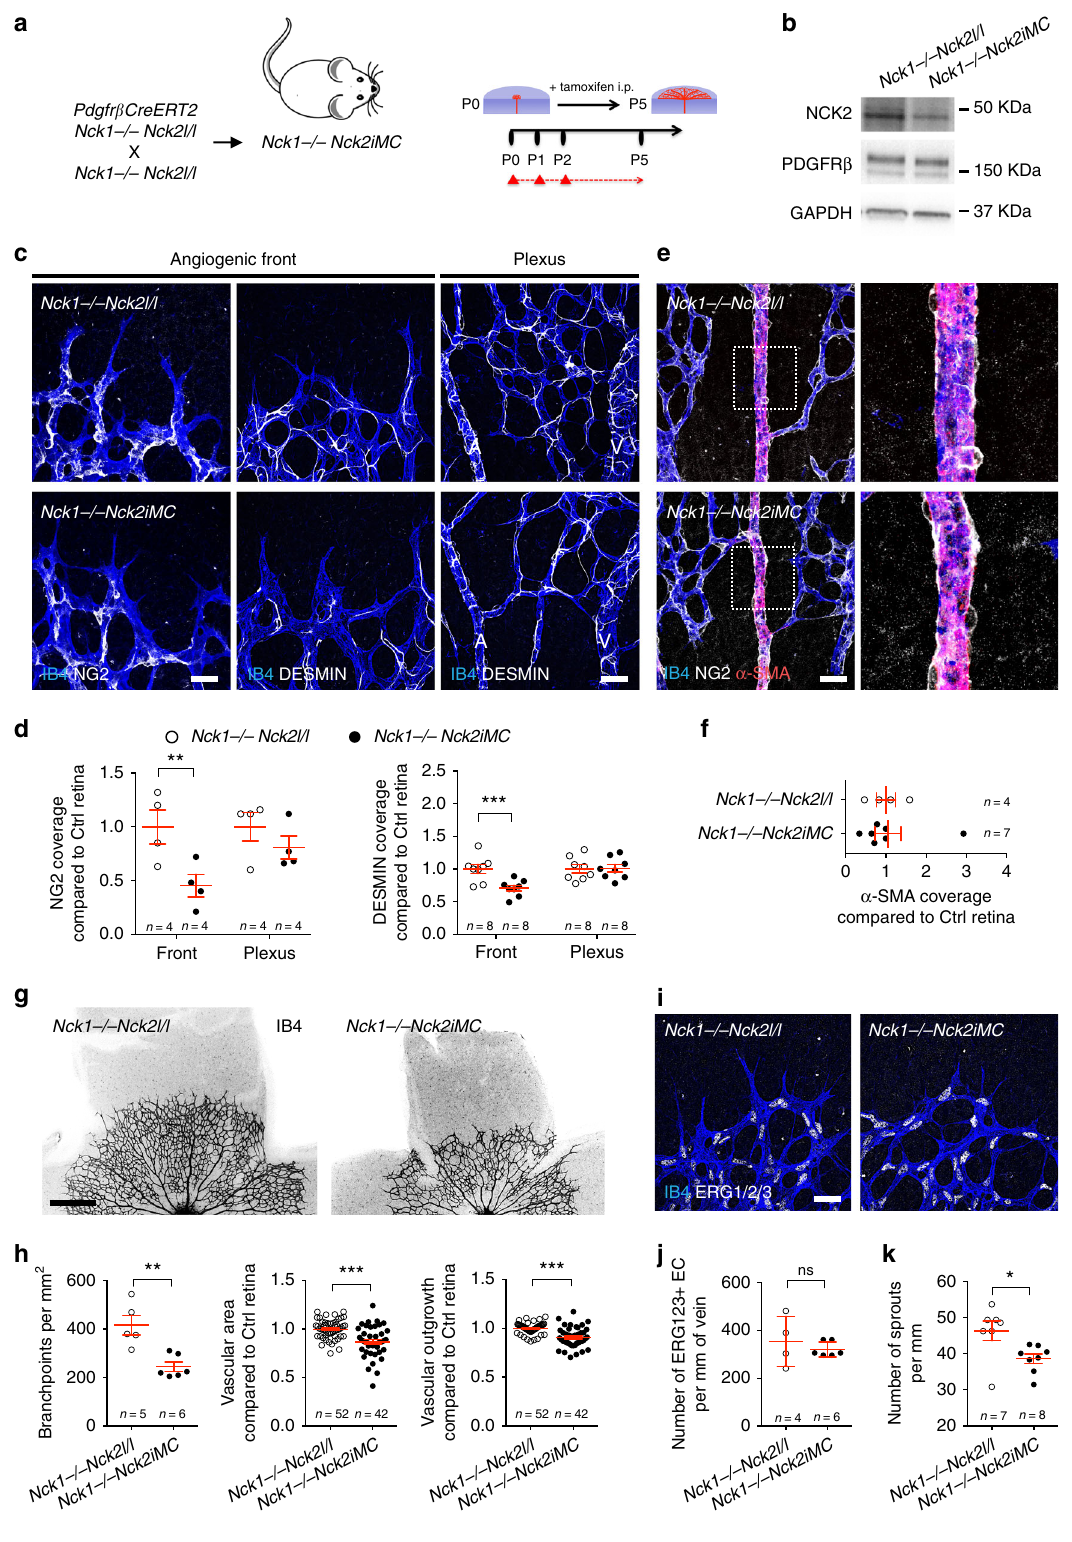
In summary, this study shows that hypoxia creates a vascular niche for pericyte activation in the ischemic retina. Activated pericytes expressing α -SMA promote pathological angiogenesis and inhibit retinal revascularization in OIR, con fi rming that pericyte identity and function are essential for vessel